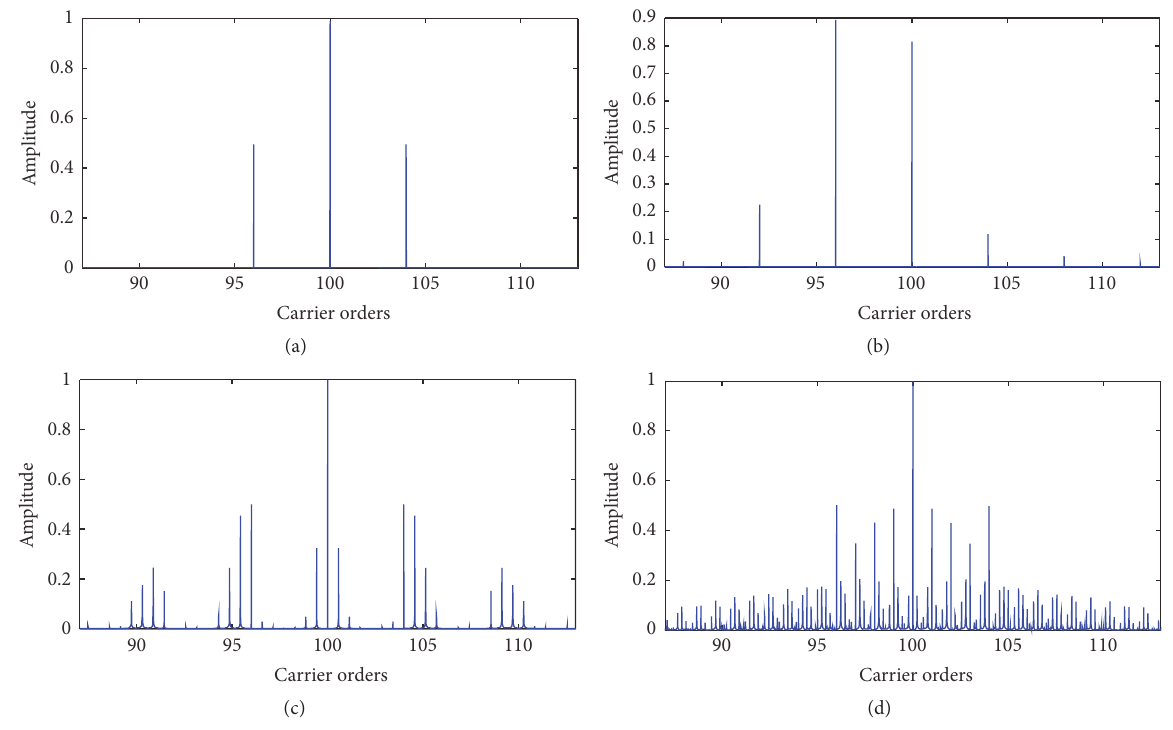
Figure 2: Predicted vibration spectrum around the fundamental gear mesh frequency picked by a fixed vibration sensor on the annulus for = 100 , 𝑁 = 28 , 𝑁 = 36 , and 𝑃 = 4 ; (a) healthy case; (b), (c), and (d) a local gear fault on the annulus, sun, and one planet gear, 𝑁 𝑎 𝑠 𝑝 respectively.